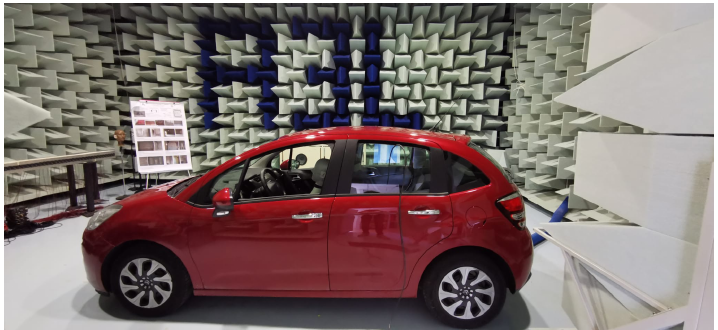
Figure 2. Car used for the experiments with the B&K mannequin. The experiments were performed inside the semi-anechoic chamber of the A3Lab group at Università Politecnica delle Marche. Several experiments were performed, considering the driver and passenger